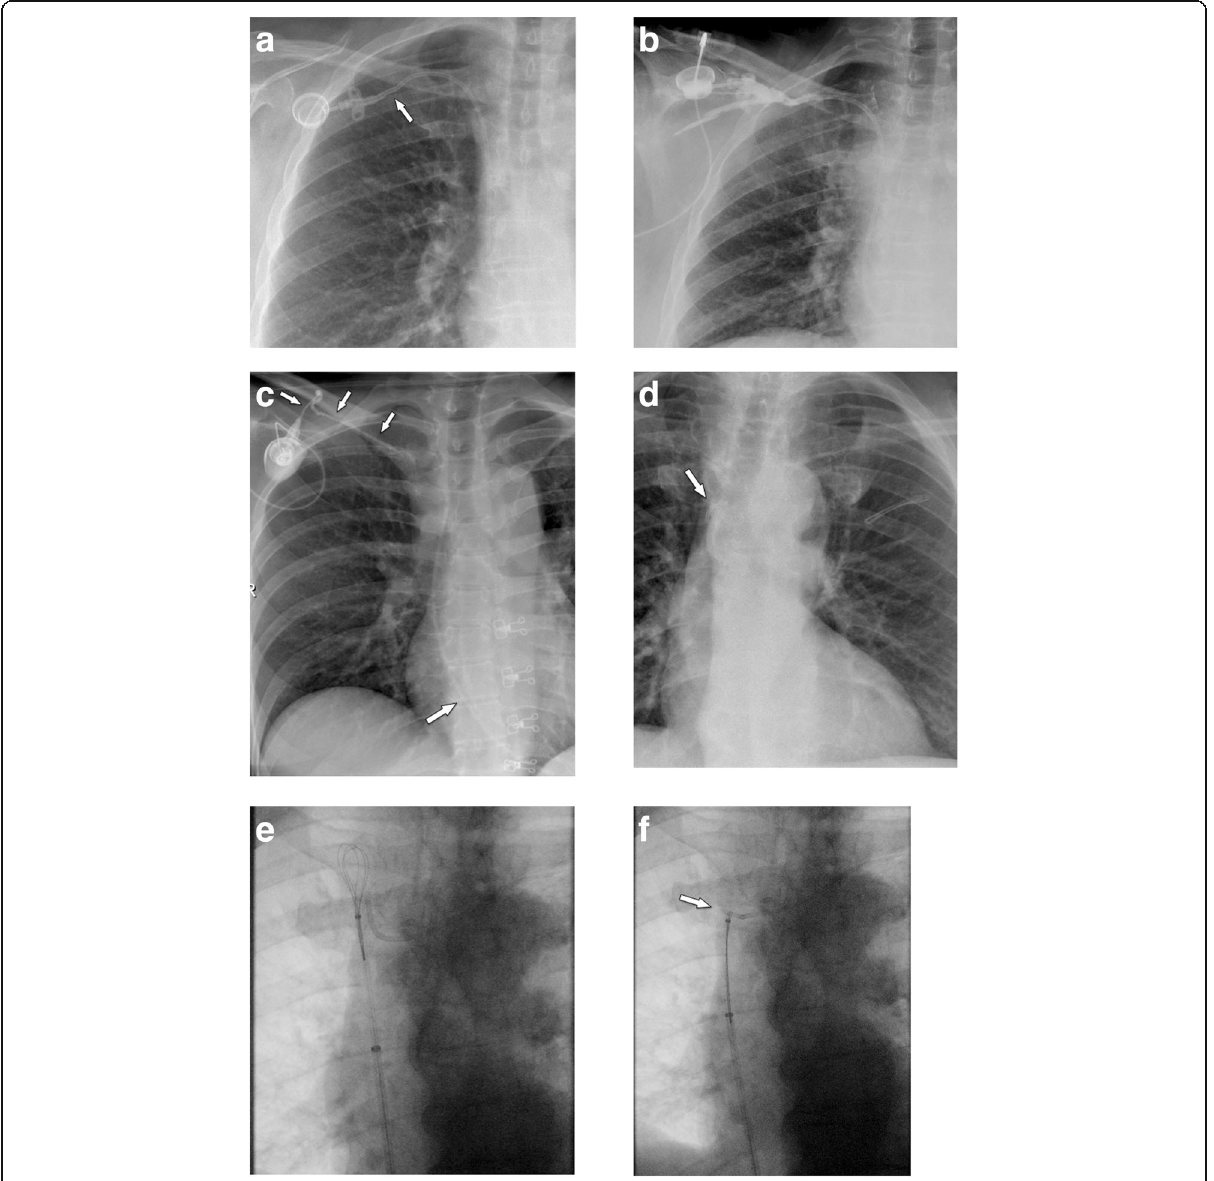
Fig. 10 Catheter pinch-off, disconnection, and fracture. a , b Catheter pinch-off with subsequent fracture. a Chest radiographs show a slight kink and pinch-off of the catheter at the thoracic inlet (between clavicle and first rib). b Five months later, a flow confirmation study shows extravasation at the thoracic inlet (due to fracture). Incidental note is made of the catheter tip in the right atrium. c Catheter disconnection in another patient: the entire catheter has gone off and embolized in the heart (large arrow). Only the subcutaneous fibrous tunnel is opacified with contrast (small arrows). d – f Fracture of catheter and percutaneous removal. d After explantation of a port system, a catheter fragment is still visible (arrow). e Via a right femoral vein access a snare is advanced toward the catheter tip. f After pulling the snare tight around the catheter (arrow), it can be safely